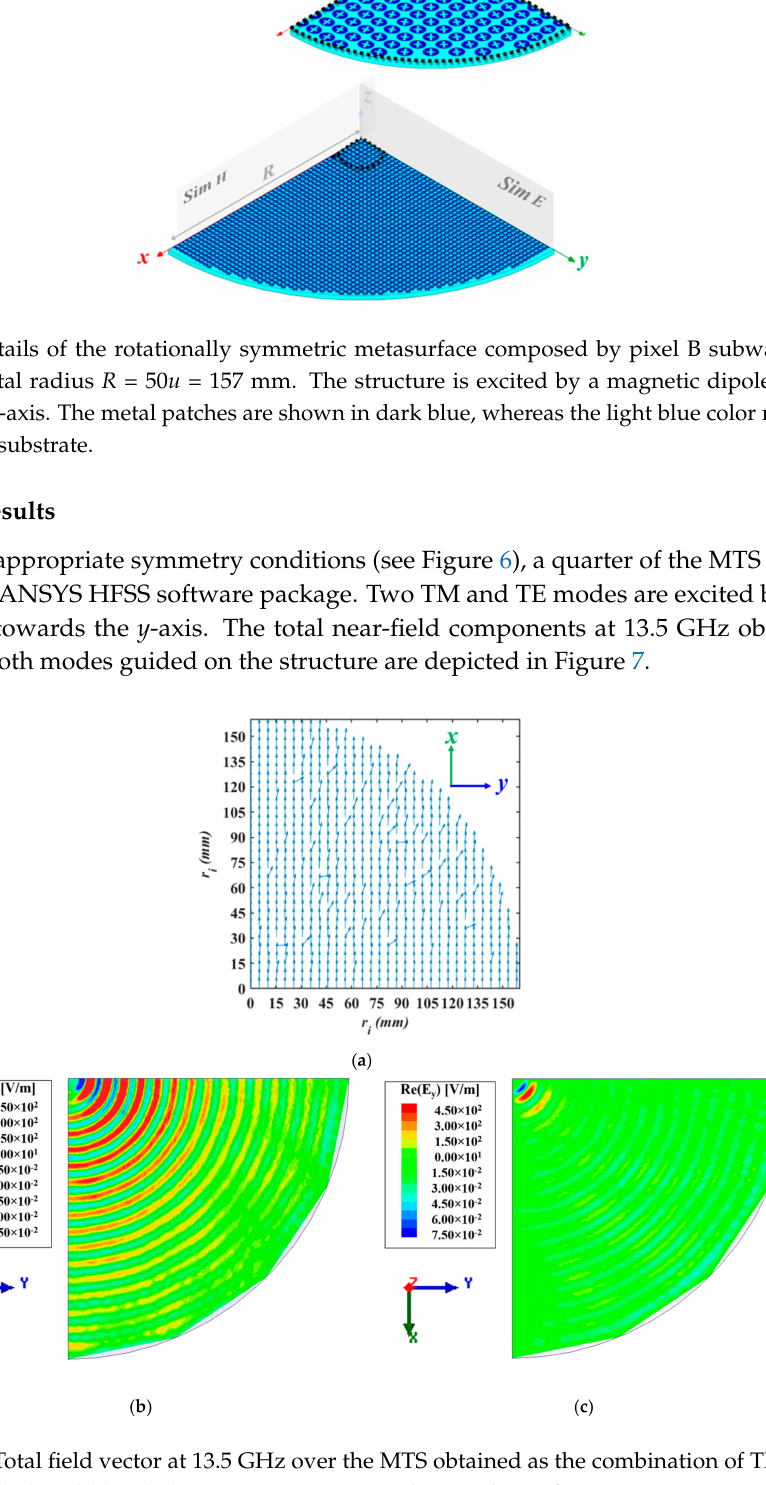
Figure 7. ( a ) Total field vector at 13.5 GHz over the MTS obtained as the combination of TM and TE modes; ( b ) Re ( E x ) and ( c ) Re ( E y ) components’ magnitude over the